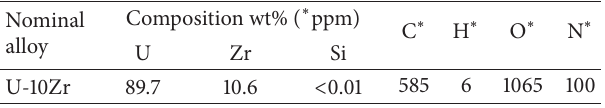
Table 3: Chemical composition of U-10Zr alloy particles by ICP- AES and EA